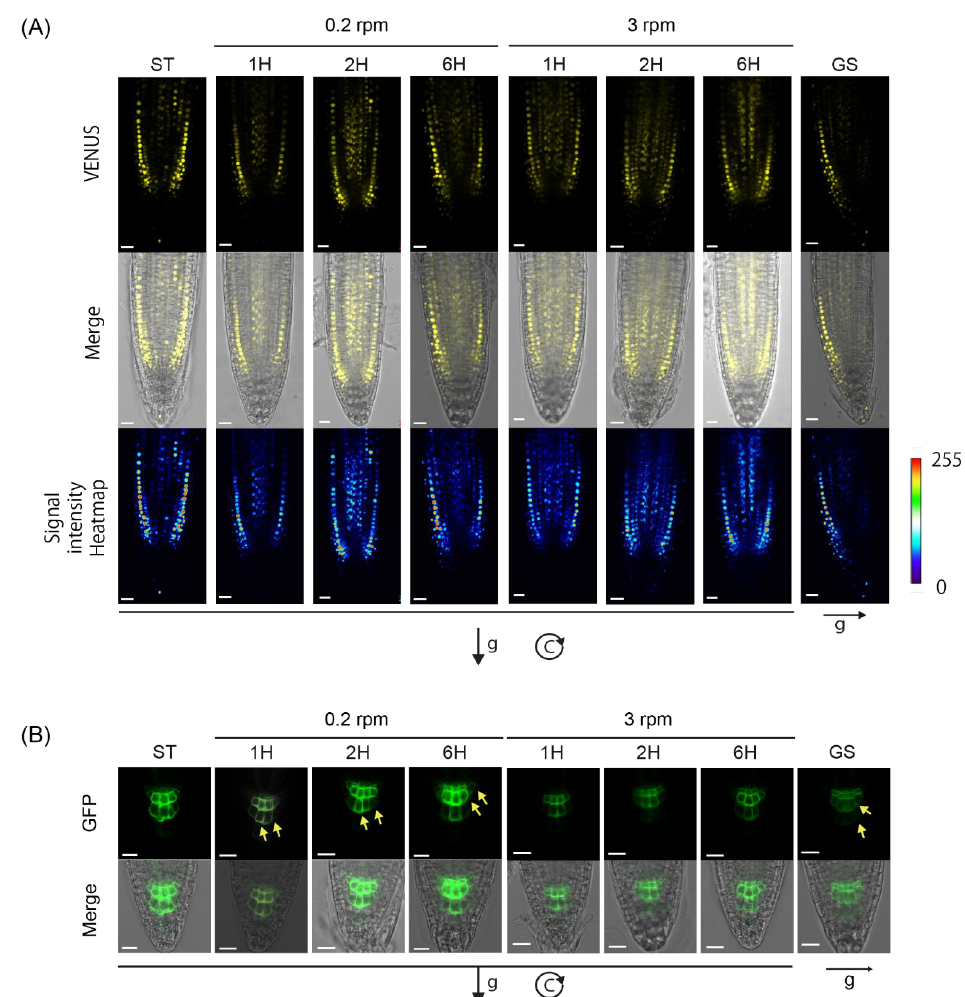
Figure 5. Low-speed vertical clinorotation leads to asymmetric auxin distribution across the root tip: 5-day-old transgenic Arabidopsis thaliana seedlings (Col) expressing the DII::VENUS auxin reporter were subjected to 0.2 RPM ( left ) or 3 RPM ( right ) vertical clinorotation in darkness for the time periods indicated above each picture. Non-clinorotated (ST) and constantly gravistimulated (GS) controls were included in this experiment. Panel ( A ) shows representative confocal images of root tip DII::VENUS fluorescence signals under the rotation conditions and times defined at the top; the middle images show the confocal DII-VENUS fluorescence signals merged with bright field views of the same roots; the bottom images show the results of signal quantification in the form of signal intensity heatmaps generated using the LUT plug-in from the ImageJ. Scale bars represent 50 µm. Panel ( B ) demonstrates how low-speed clinorotation leads to mild PIN3 relocalization in the columella cells of the root cap. 5-day-old transgenic Arabidopsis thaliana seedlings (Col accession) expressing a PIN3-GFP construct were either clinorotated at 0.2 and 3 RPM in darkness, gravistimulated, or grown straight downward without clinorotation or gravistimulation (ST) for 0, 1, 2, or 6 h. The PIN3-GFP fluorescent signal was then analyzed by confocal microscopy. A mild polarization of the signal appeared in the columella cells of the root cap (yellow arrows) within 1 h of 0.2 RPM clinorotation and continued over a period of 6 h. Similar polarization was not seen upon 3 RPM clinorotation or when the seedlings were neither gravistimulated nor clinorotated. Quantification of VENUS signals from panel ( A ) were presented in Supplemental Figure S7A. In panels ( A ) and ( B ), the direction of gravity (g) at the onset of clinorotation (or gravistimulation, GS) is represented by a black